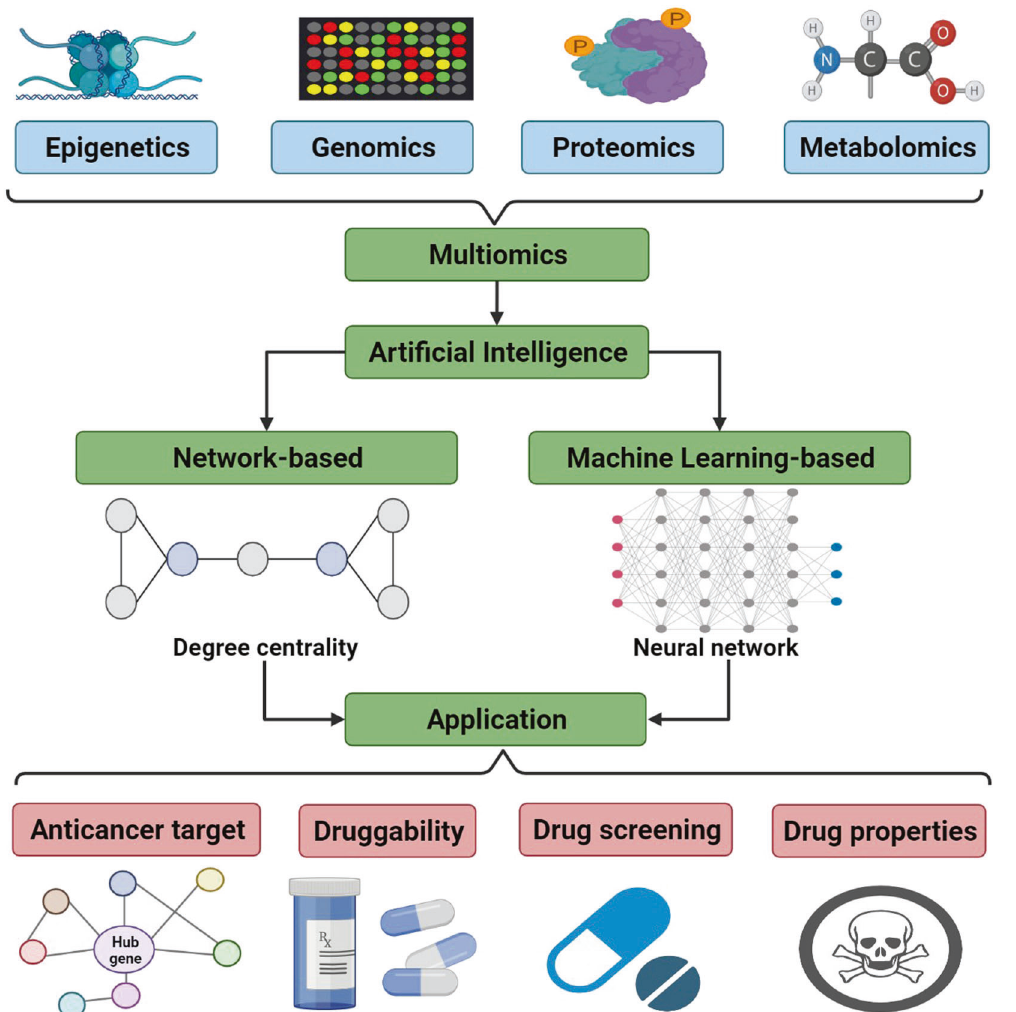
Fig. 2 Arti fi cial intelligence to integrate multiomics data (e.g., epigenetics, genomics, proteomics, and metabolomics) for cancer therapeutic targets identi fi cation. (Created with